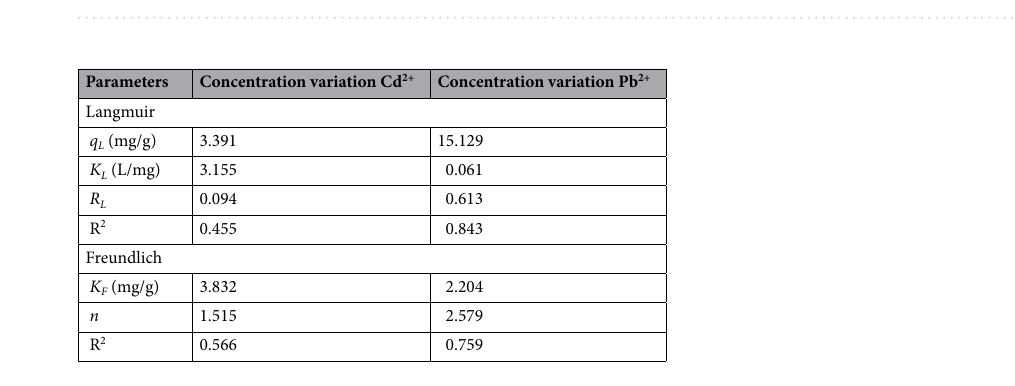
Table 3. Adsorption of Pb 2+ by magnetite at different pH values, concentrations and contact times over 60 min of contact time.